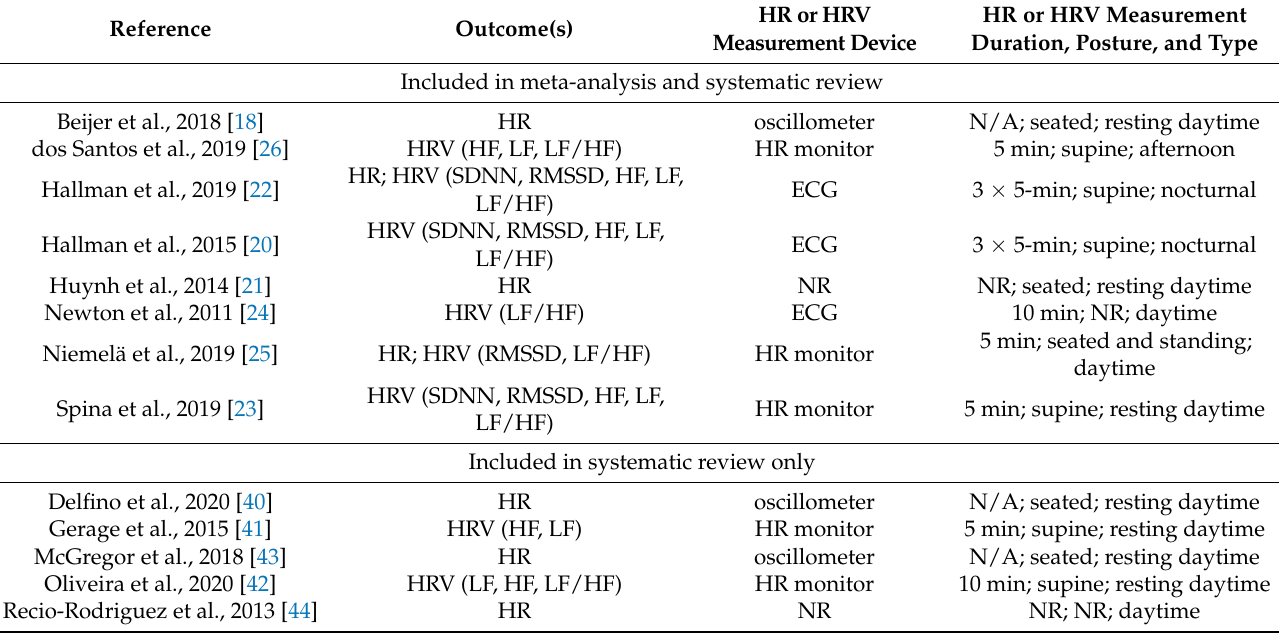
Table 2. Description of outcomes from the included